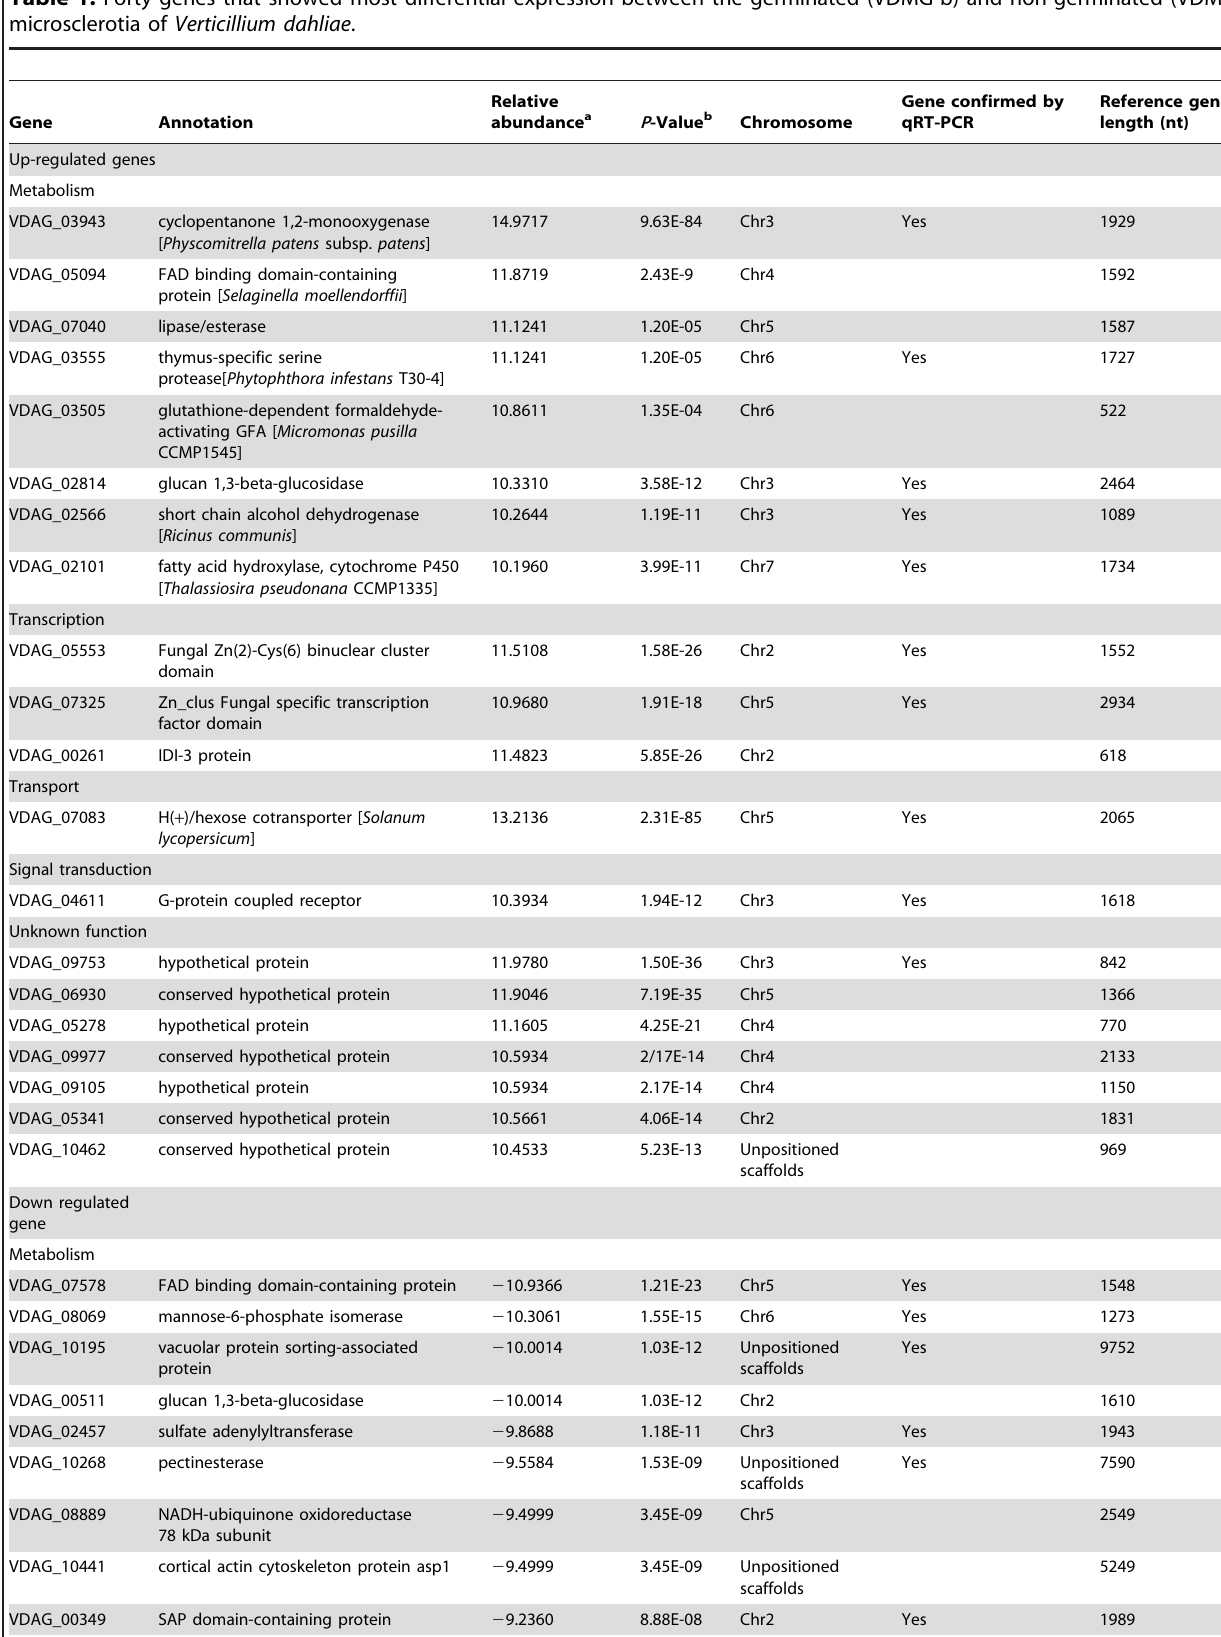
Table 1. Forty genes that showed most differential expression between the germinated (VDMG-b) and non-germinated (VDM) microsclerotia of Verticillium dahliae